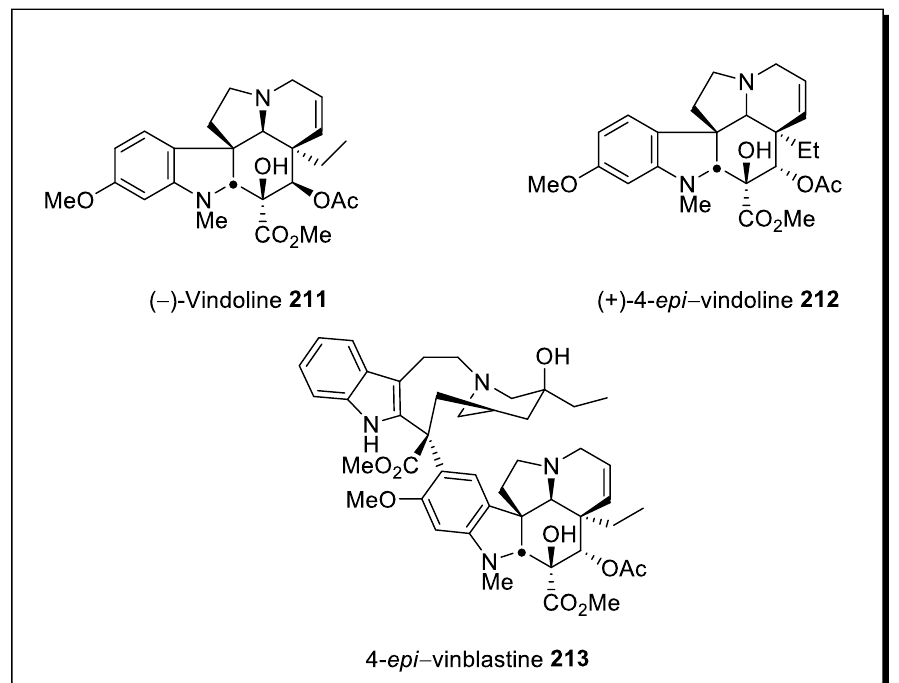
Figure 2. Structures of (−) -vindoline 211 , (+)-4- epi- vindoline 212 and 4- epi- vinblastine 213 . Boger and co-workers reported an efficient synthetic protocol in which the intramo- lecular [4+2]/[3+2] cycloaddition of 1,3,4-oxadiazoles was initiated by allene dienophile